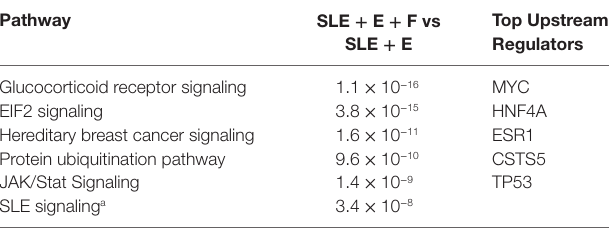
TaBle 4 | The top five canonical pathways affected by the estrogen receptor- alpha (ER α ) antagonist, Faslodex in activated systemic lupus erythematosus (SLE) T cells ( n = 9) cultured with estradiol was